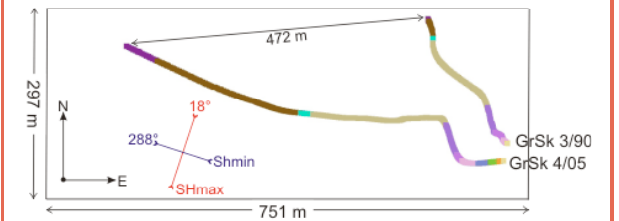
Figure 2. Top view projection of the doublet wells at Gross Schönebeck. The deviation of GrSk 4/05 is parallel to the minimum horizontal stress direction to facilitate a set of parallel hydraulic